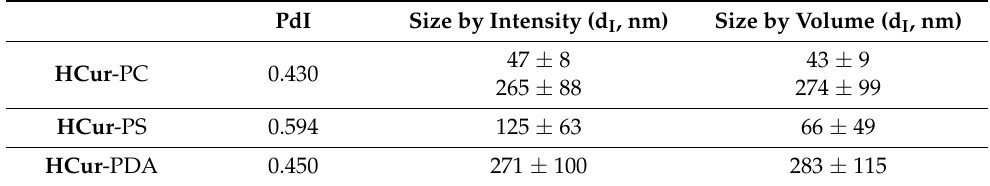
Table 1. Size distribution by volume and intensity of HCur -PC (1), HCur -PS (2) and HCur -PDA (3) at pH =